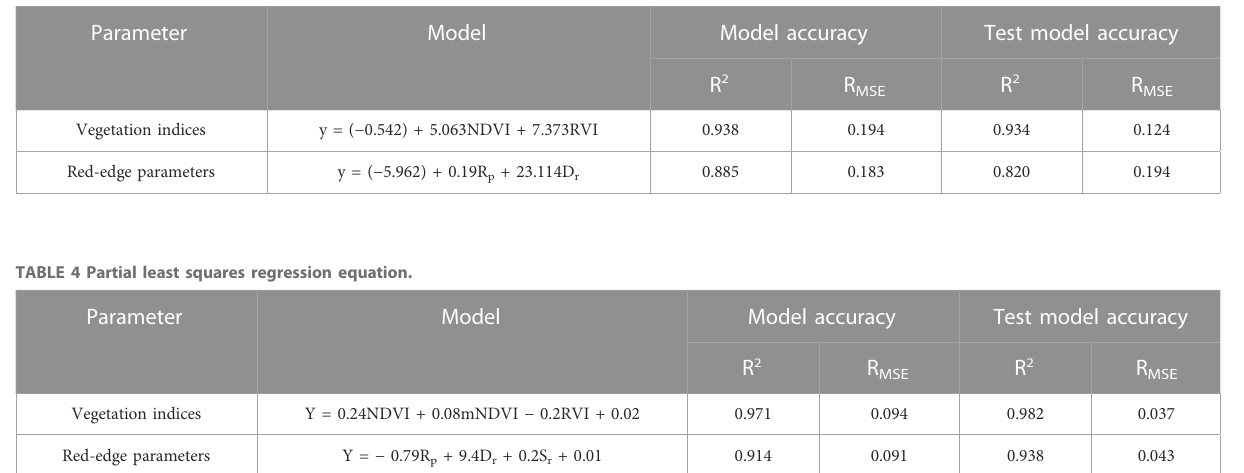
TABLE 3 Multiple stepwise regression model equation.